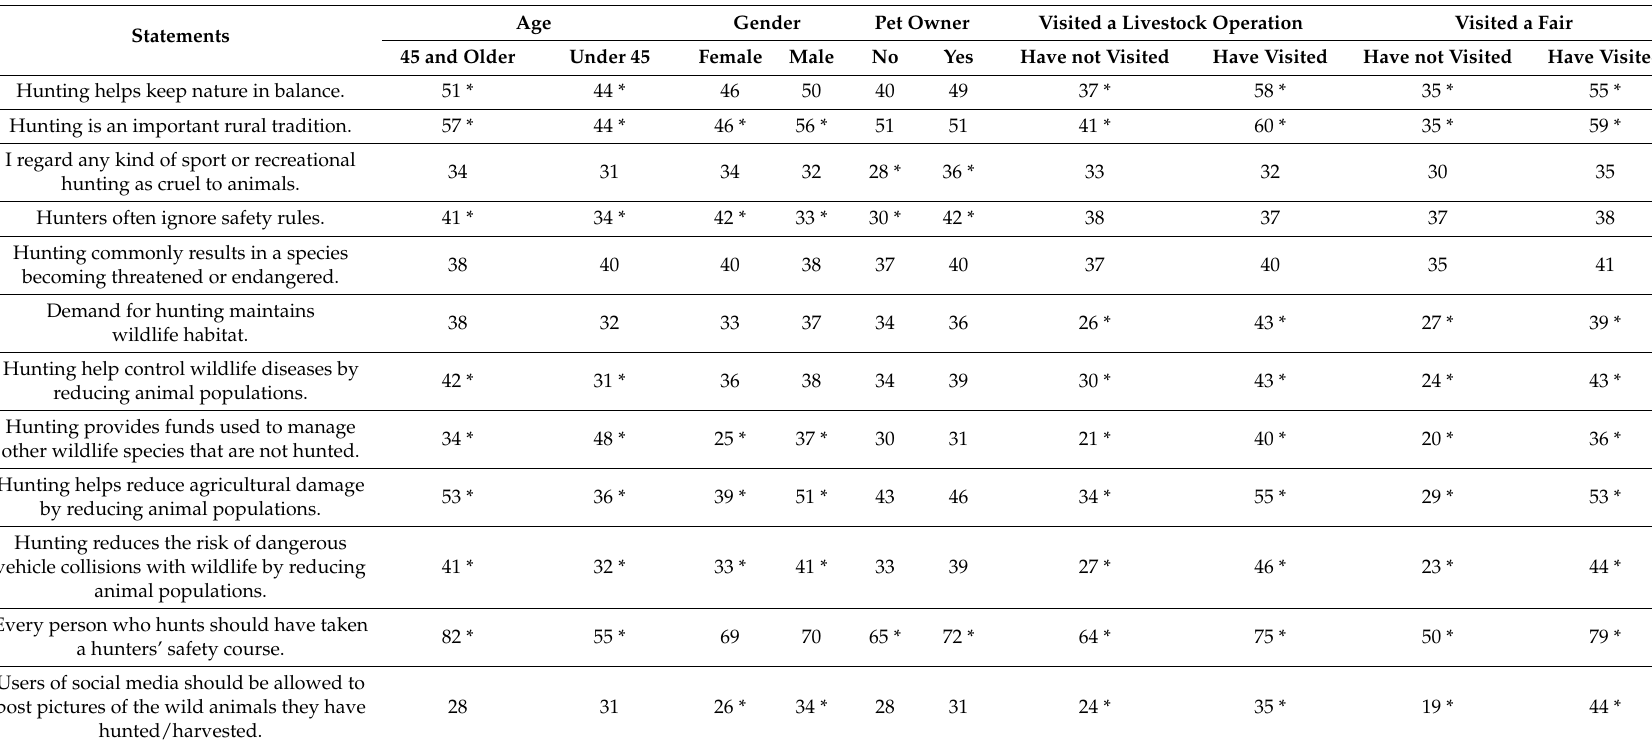
Table 1. Presentation of statistically significant differences in agreement with statements about hunting by demographic categories ( α = 0.05 denoted by “*”; n =